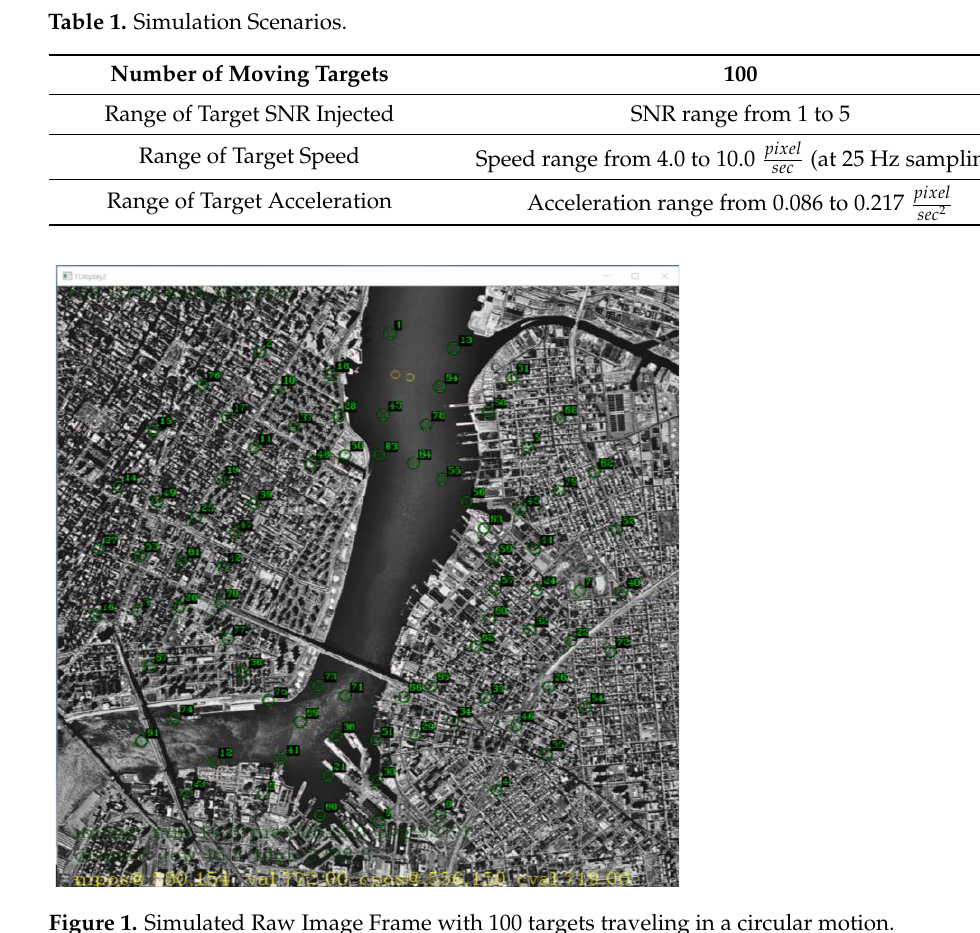
Figure 1. Simulated Raw Image Frame with 100 targets traveling in a circular motion.